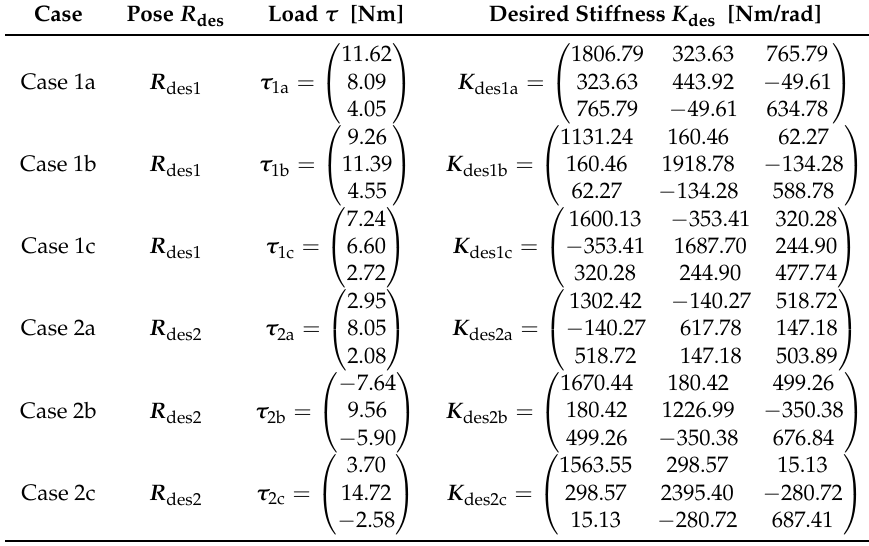
Table 1. Six sub-cases of the simulation with different desired poses, applied loads and desired stiffness